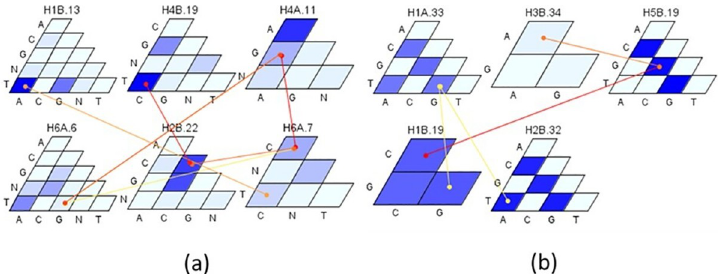
Fig 11. Additive-Additive interactions among haplotypes for yellow rust disease in PAU (a) and Toluca (b) environments. The magnitude/effect of interactions is presented with yellow and red colors where red corresponds to stronger interaction at P < 0.001.